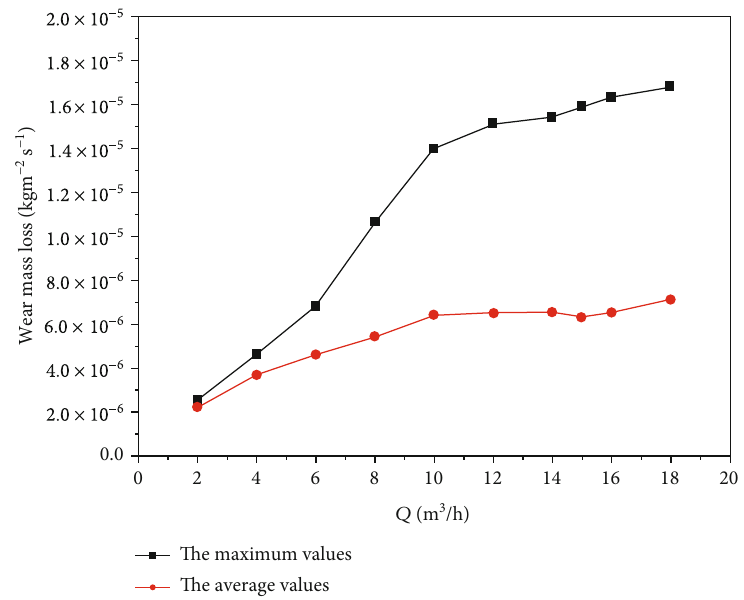
Figure 8: Variation of wear mass loss of volute material with the inlet fl ow rate.